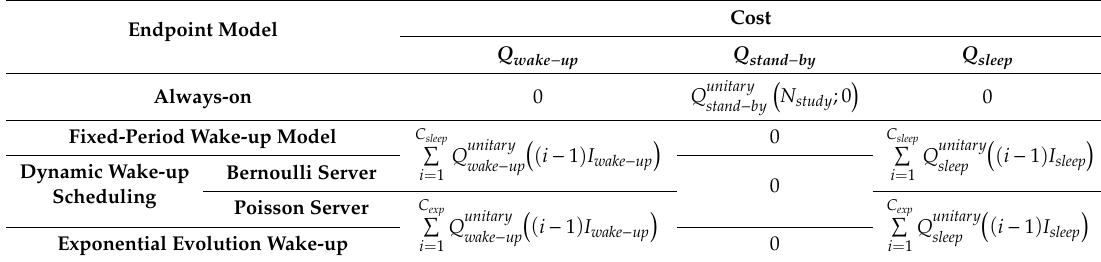
Table 3. Link management costs for di ff erent endpoint’s models.